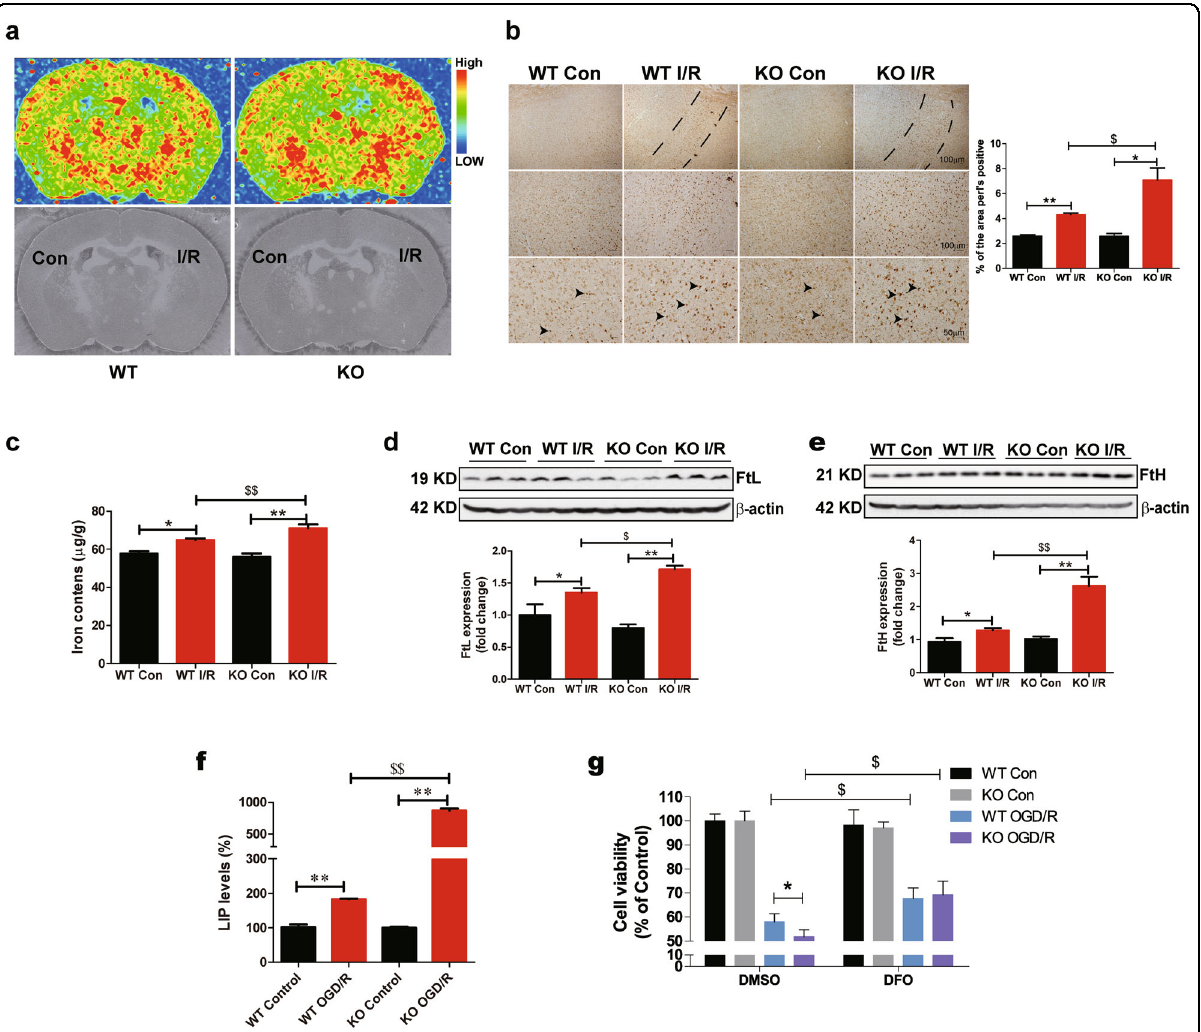
Fig. 5 Deletion of FtMt leads to an elevation in iron after cerebral I/R. a Distribution of iron in the mouse brain after I/R. The upper images show the mapping results with μ -XRF, and the iron levels in different brain regions are indicated by different colours. Blue indicates the lowest iron level, and red indicates the highest iron level, as shown in the illustration. The lower images show the morphology of the brain sections corresponding to the upper images ( n = 3). b Content and distribution of iron as determined by DAB-enhanced Perl ’ s staining and quanti fi cation of the area of Perl ’ s staining in brain sections from mice of different groups ( n = 3). The dotted zone indicates the penumbra. The arrowheads indicate positive staining of iron. c Iron content as determined by ICP-MS in wild-type and Ftmt -knockout mice 24 h after MCAO/reperfusion ( n = 6). Western blot analysis of the iron storage proteins ( d ) FtL and ( e ) FtH ( n = 5). f Primary cultured wild-type and Ftmt -knockout neurons were subjected to OGD for 5 h and reperfusion for 18 h, and the LIP levels were determined ( n = 4). g Primary cultured wild-type and Ftmt -knockout neurons were subjected to OGD treatment for 5 h and then exposed to normal medium with 0.05 μ m DFO for 18 h. Cell viability was determined using an MTT assay ( n = 6). The results are presented as the mean ± SEM. * /$ P < 0.05, ** /$$ P <